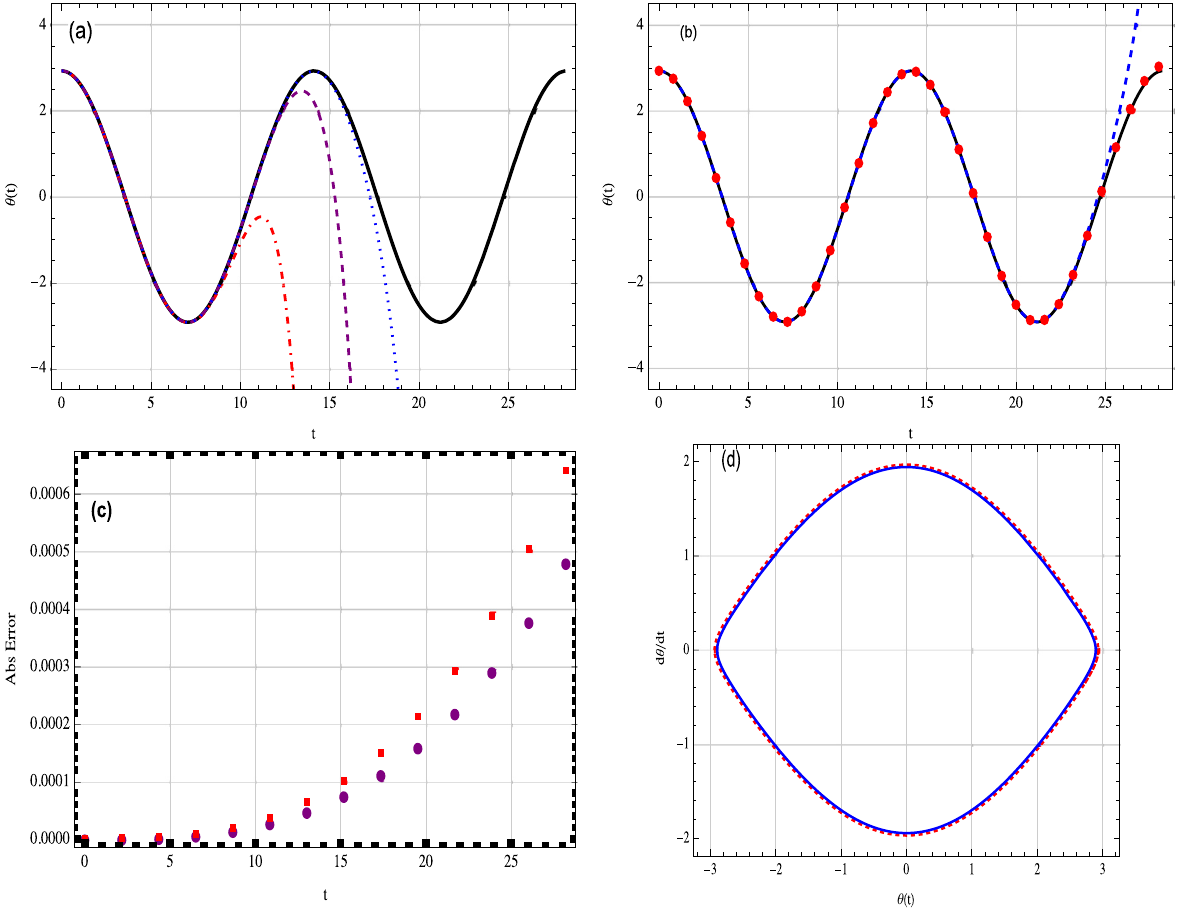
θ 35 ⟨ ⟩ with step - size h 0.3 = ( dots ) . ( c ) Absolute error k